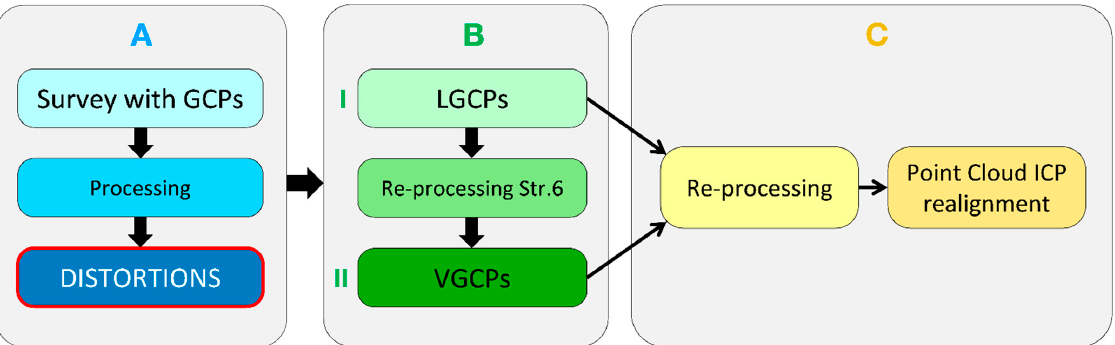
Figure 2. Methodological flowchart. ( A ) Processing of the surveys at the Sciara del Fuoco with traditional Ground Control Points (GCPs) that pointed out distortions and alignment issues. ( B ) Use of LiDAR Ground Control Points (LGCPs) (I) to re-process the Stromboli 6 dense cloud and identification of stable Virtual Ground Control points (VGCPs) (II). ( C ) Final re-processing of all the surveys using LGCPs and VGCPs and use of the ICP alignment tool. Surveys have been carried out with the drone Saturn, entirely designed, developed, and patented by the Department of Earth Sciences of the University of Florence [24].